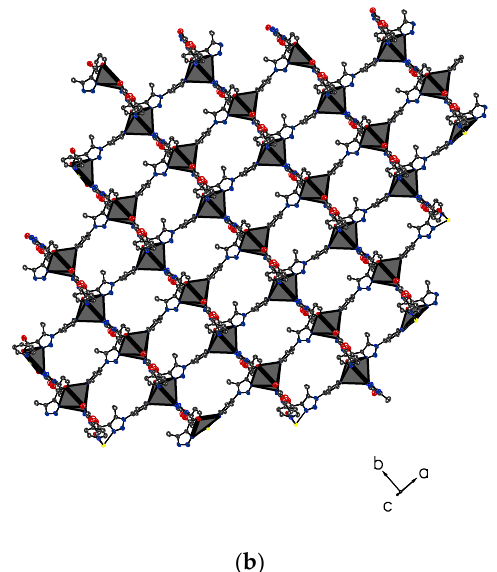
Figure 7. Three-dimensional (3-D) metalorganic frameworks along to plane (100) ( a ) and the plane (111) ( b ).